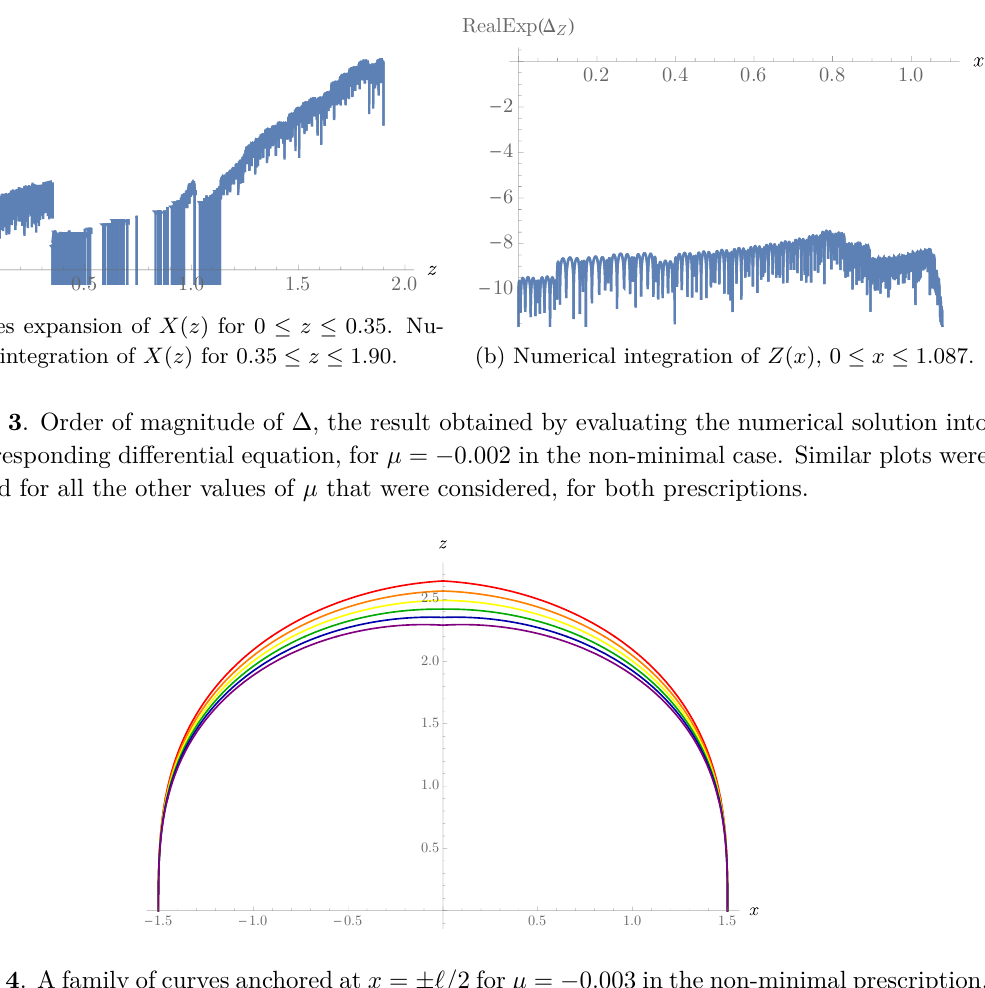
Figure 4 . A family of curves anchored at x = ± ‘/ 2 for µ = − 0 . 003 in the non-minimal prescription. This set of curves was obtained by varying the initial parameter (related to the third derivative X 000 ( z ) at z = 0 ) from − 0 . 30 to − 0 . 40 in steps of − 0 . 02 . The curve identified as the actual entanglement surface for this case has an initial parameter close to − 0 . 346